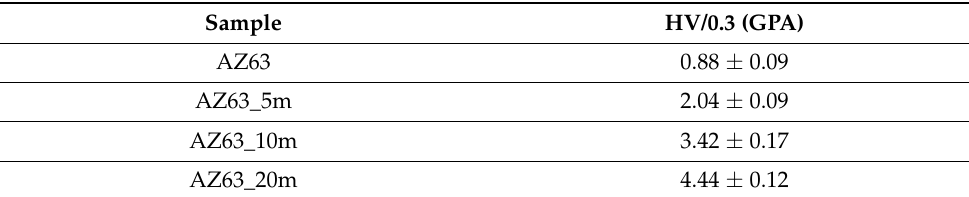
Table 7. Coating Vickers